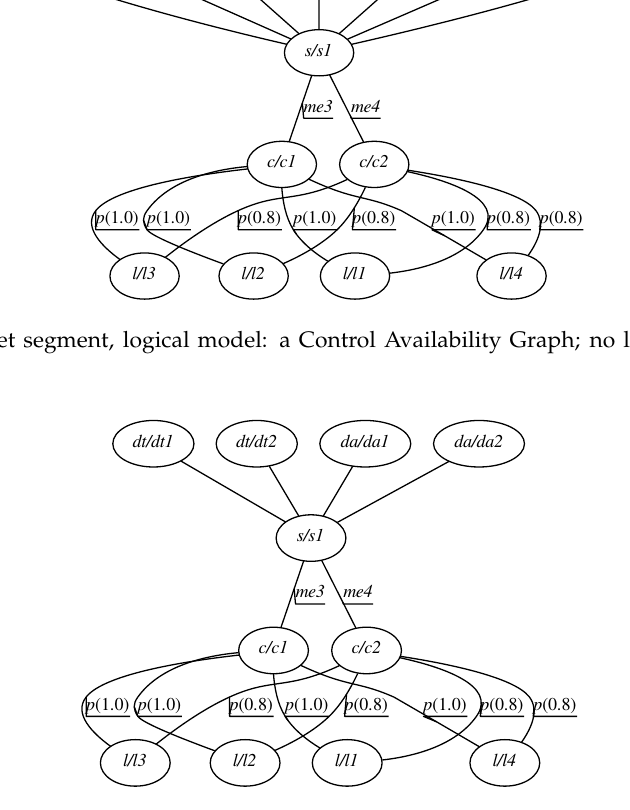
Figure 5. A street segment, logical model: a Control Availability Graph; a simplified approach which takes into account a subset of